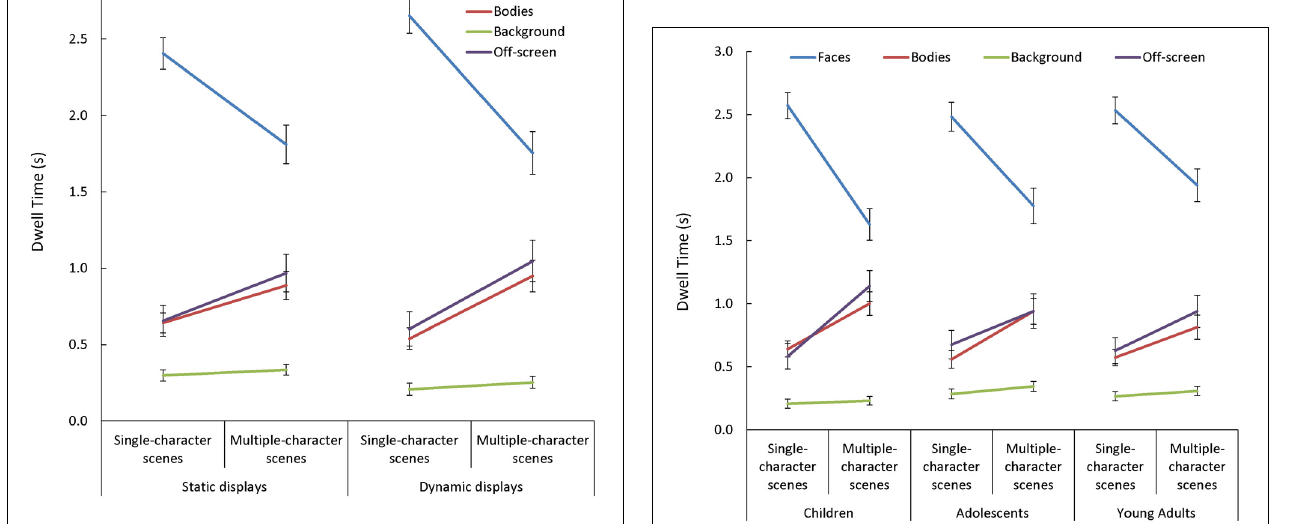
FIGURE 7 | Age-related changes in mean dwell time (s) in each area of interest (AOI; faces, bodies, backgrounds) and off-screen, for both single- and multiple-character scenes. Although adding more characters to the scene triggered all participants to shift their attention from faces to bodies or off screen, these effects were larger in children than in